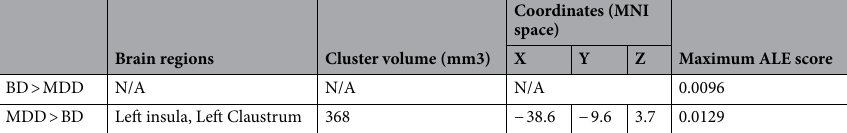
Table 2. Meta-analysis results of the resting state activity differences in subjects with MDD compared to BD in both directions. Maximum ALE score represents the highest ALE value in the cluster. ALE activation likelihood estimation, BD bipolar disorder, MDD major depressive disorder, N/A not applicable.